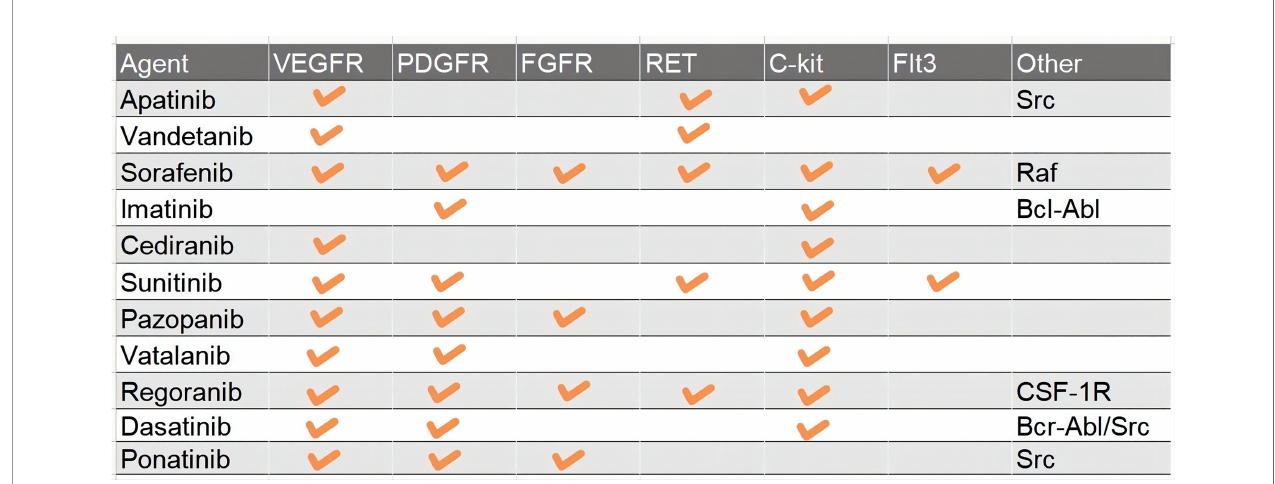
FIGURE 3 | A table which summary the major targets of